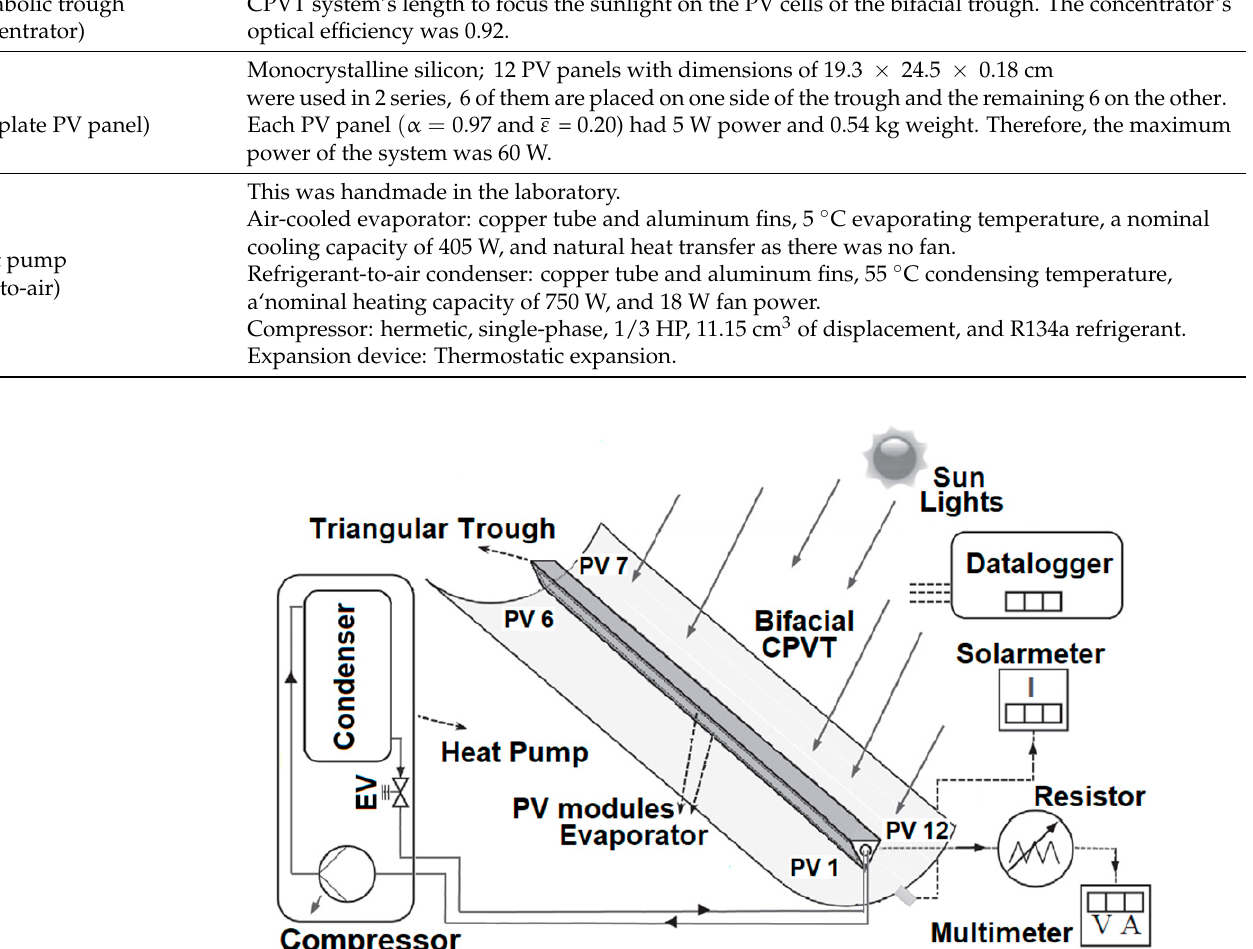
Figure 2. Schematic diagram of the bifacial CPVT system with a heat pump.